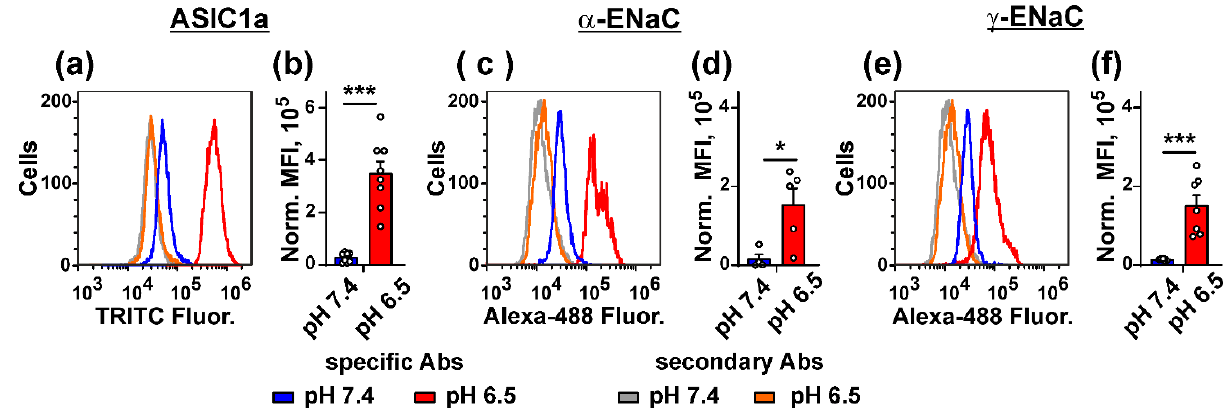
Figure 4. Influence of media acidification on expression of the ASIC1a ( a,b ), α -ENaC ( c,d ), and γ -ENaC ( e,f ) subunits in mel P cells: representative cell distribution histograms of the ASIC1a ( a ), α -ENaC ( c ), and γ -ENaC ( e ) subunits stained on the surface of mel P cells; expression levels of the ASIC1a ( b ), α -ENaC ( d ), and γ -ENaC ( f ) subunits. Data presented as normalized MFI ± SEM ( n = 7–8). * ( p < 0.05) and *** ( p < 0.001) indicate significant